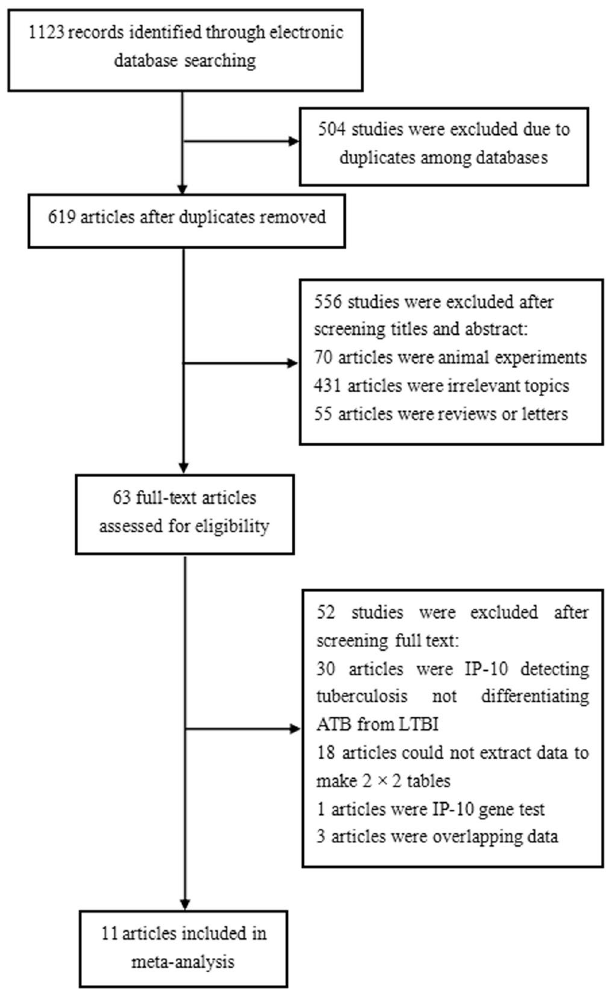
Figure 1. Flow chart of the identified and included articles. 1123 literature citations were identified from 8 databases (English databases: 925, Chinese databases: 198). After removing 504 duplicates, we read titles and abstracts and excluded 556 records (70 records focused on animal experiments, 431 records were irrelevant topics, and 55 records were reviews, abstracts or letters which beside the point). Ultimately, 11 articles including 15 trials were